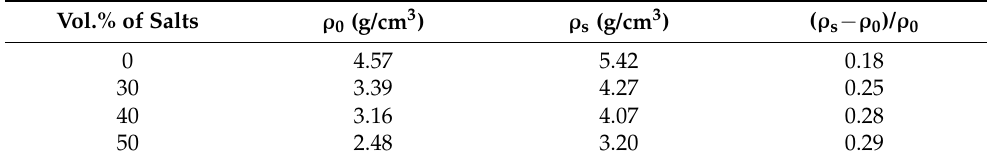
Table 1. Green and sintered densities of all samples as well as densification reached after sintering. Vol.% of